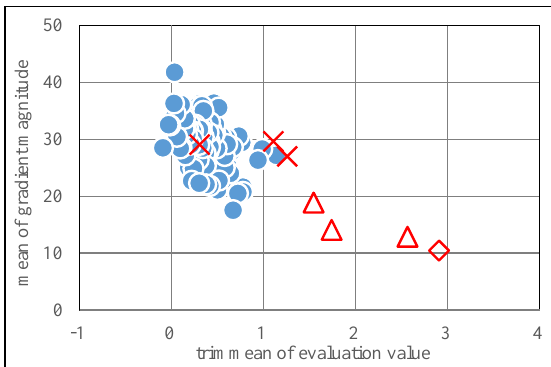
Figure 12 Classification results by trimmean